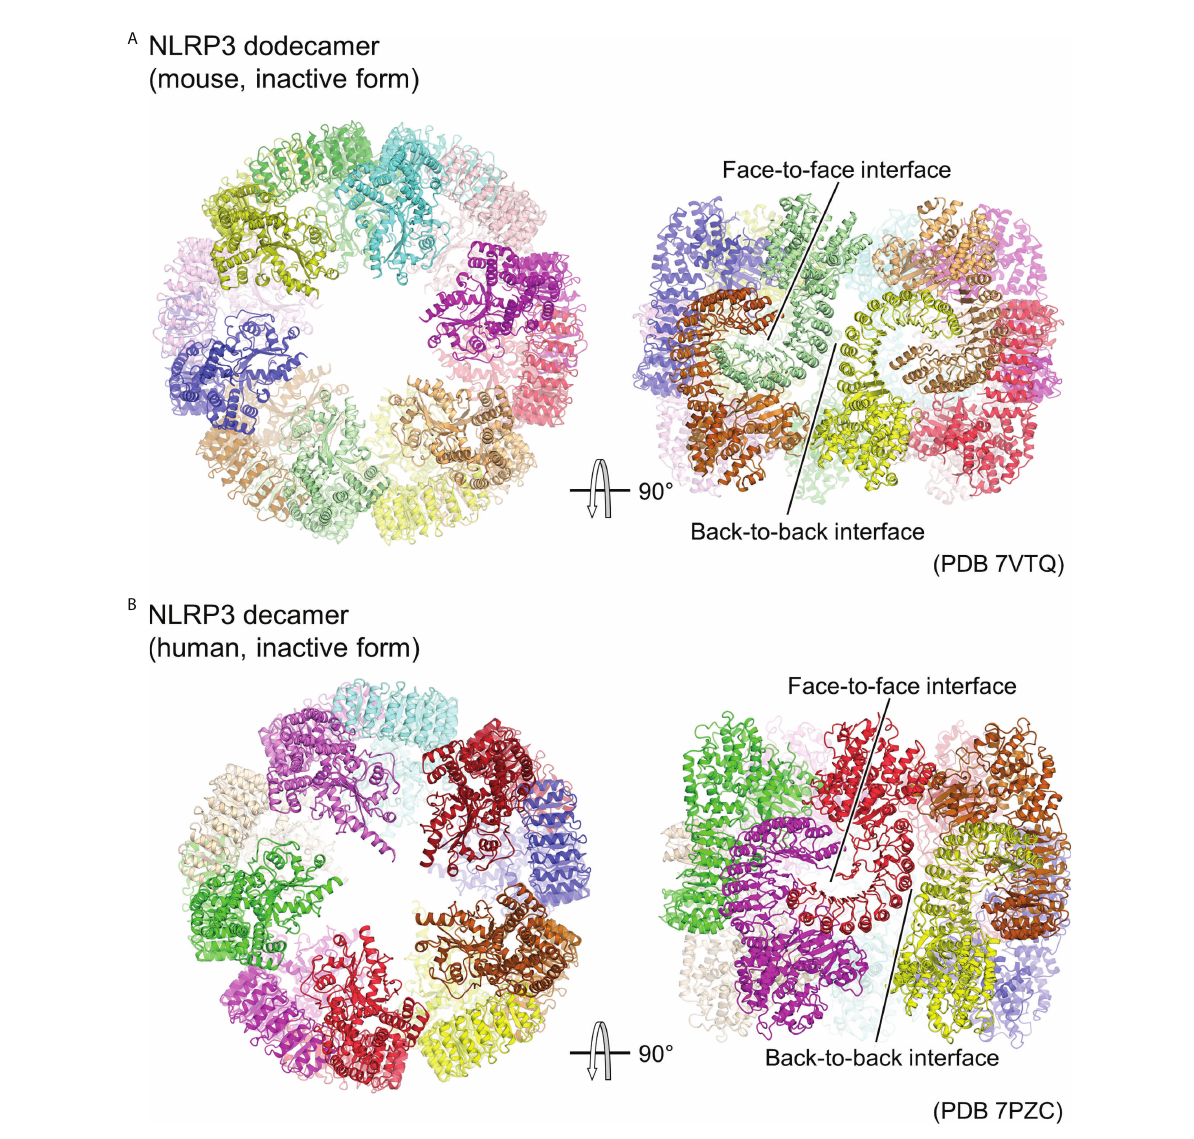
FIGURE 3 Cage-shaped inactive oligomer of NLRP3. Top and side views of the structure of (A) full-length mouse NLRP3 dodecamer (PDB 7VTQ) (23) and (B) Human NLRP3 decamer (PDB 7PZC) (24). Each protomer is shown in a different color. The LRR-mediated oligomer interfaces are